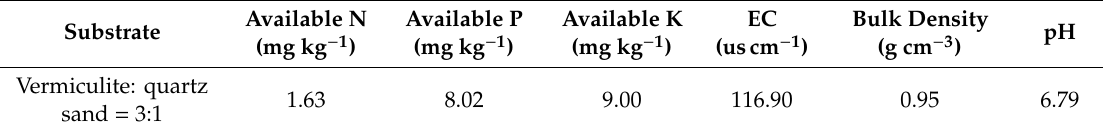
Table 1. Physical and chemical properties of medium.